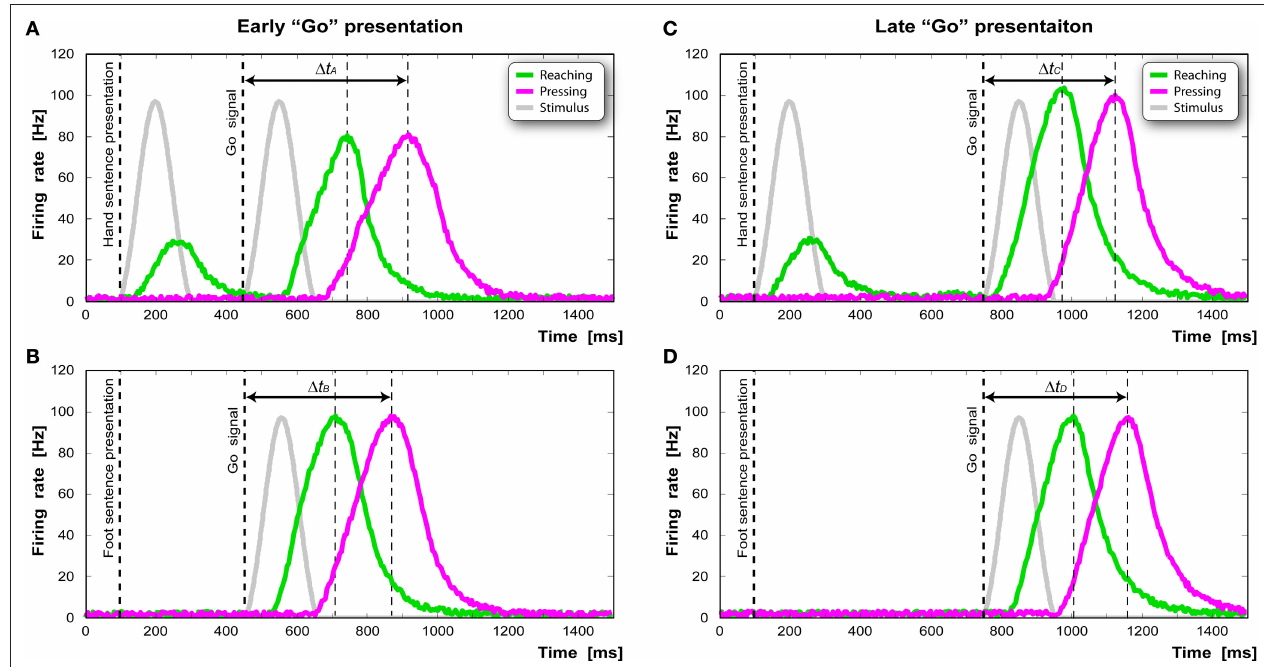
presentation, the “reaching-pressing” chain responds slower when the hand sentence was presented (A) compared to when the foot sentence was presented (B) . In case of late “Go” presentation, the effect is the opposite [ (C) vs. (D) ].